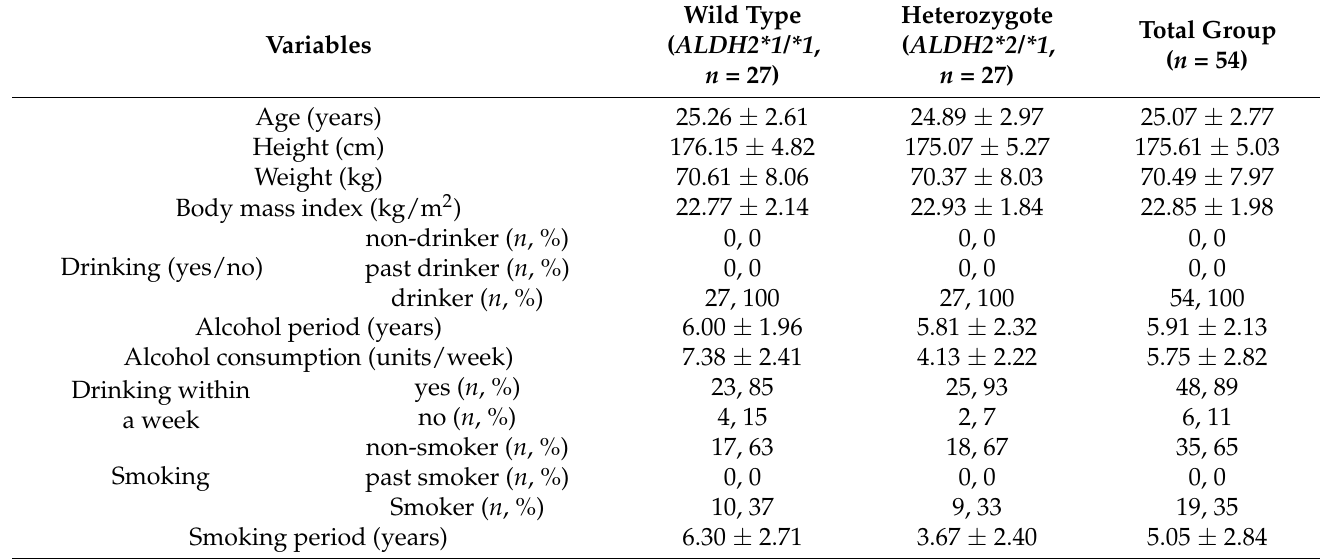
Table 1. Demographic characteristics of the study